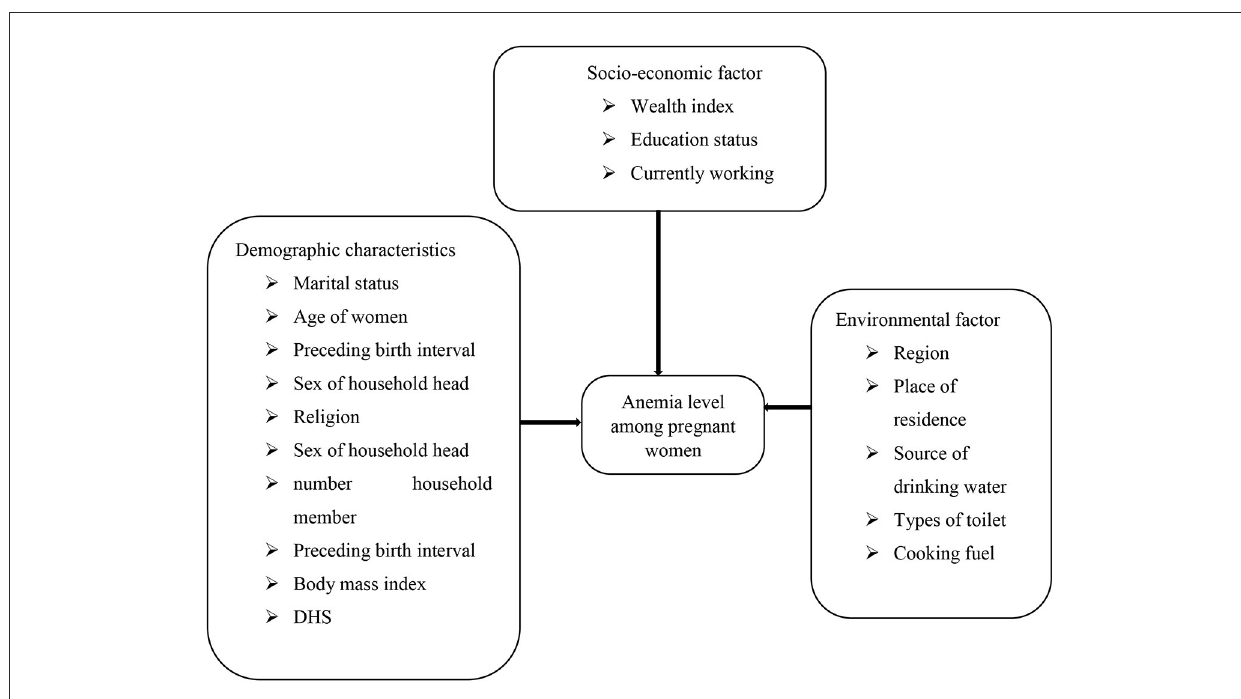
FIGURE2 Conceptual framework for dependent and independent variables.